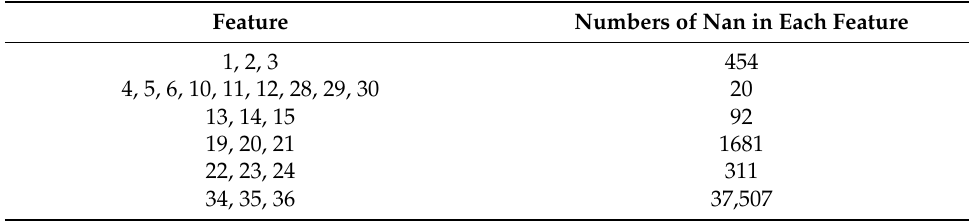
Table 2. Number of missing values in the first